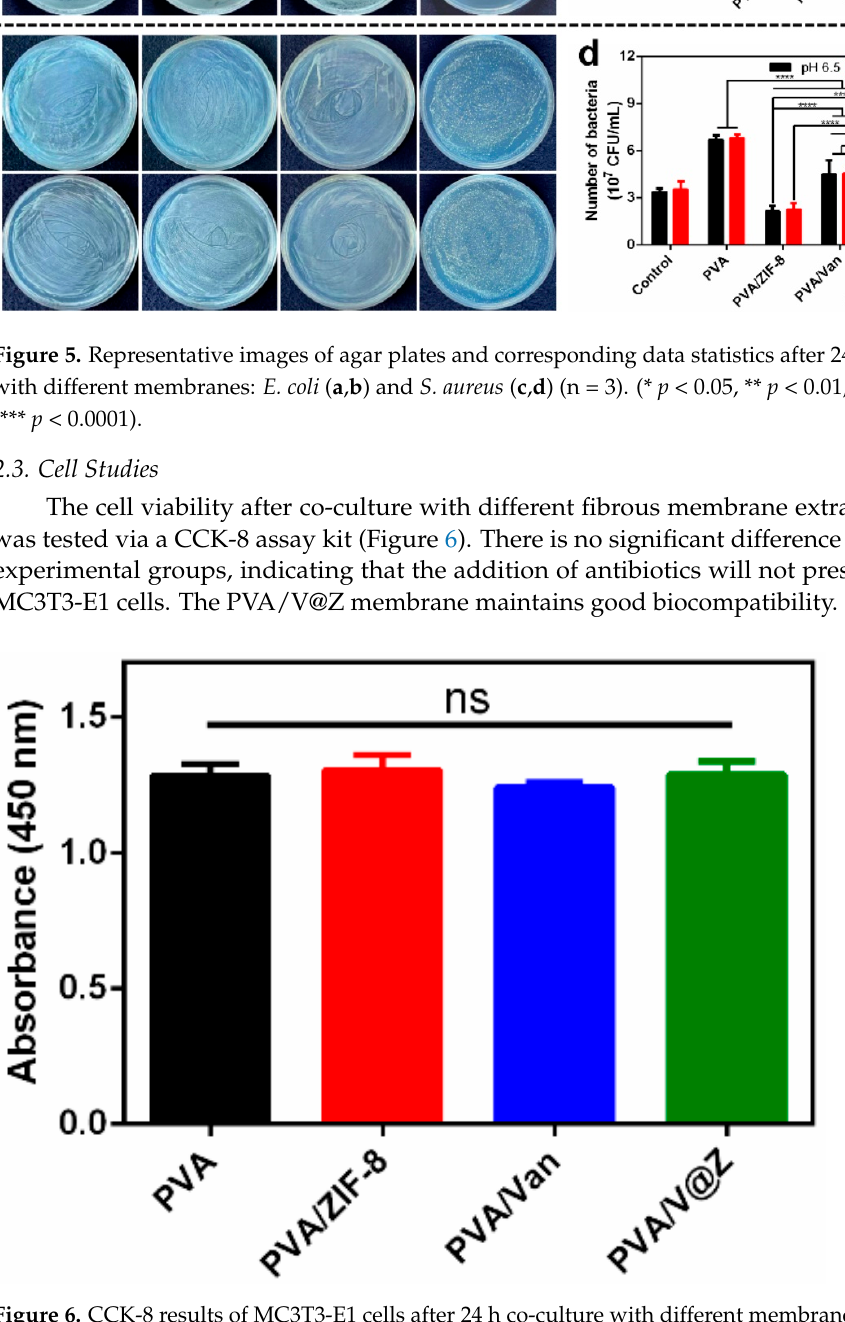
Figure 6. CCK-8 results of MC3T3-E1 cells after 24 h co-culture with different membranes (n = 5). (ns, not significant)